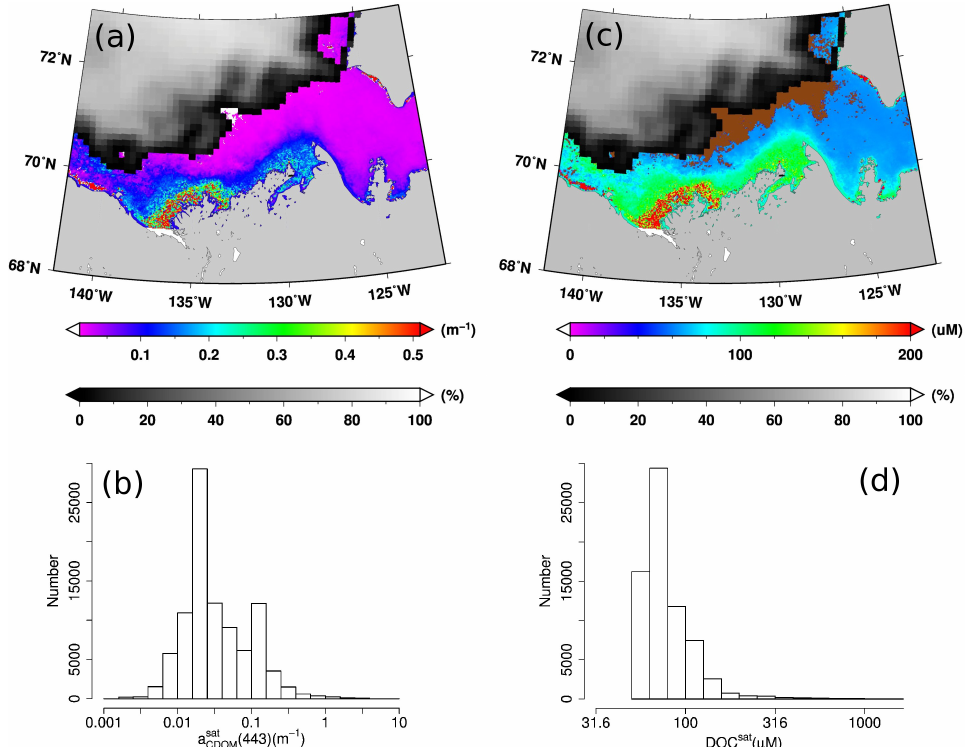
Fig. 5. (a) A composite image of CDOM absorption, a sat (443) for August 2009 using three weeks of MODIS R rs (λ) data, with sea ice CDOM concentration shown in gray. (b) Histogram of a sat (443) values shown in (a) . (c) An image of DOC concentration, DOC sat for August CDOM 2009 using our DOC vs. a CDOM (443) algorithm applied to the image shown in (a) . DOC sat concentrations lower than 61µM (outside the regression of DOC vs. a CDOM (443) relationship) are masked as brown. (d) Histogram of DOC sat values shown in (c)